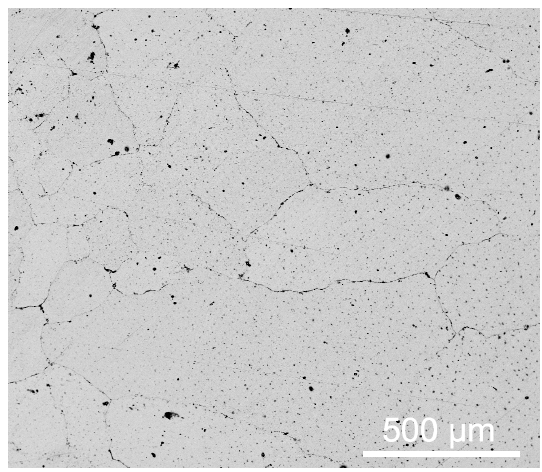
Figure 1. Scanning electron microscope (SEM) image of the microstructure of the as-received Hadfield steel.